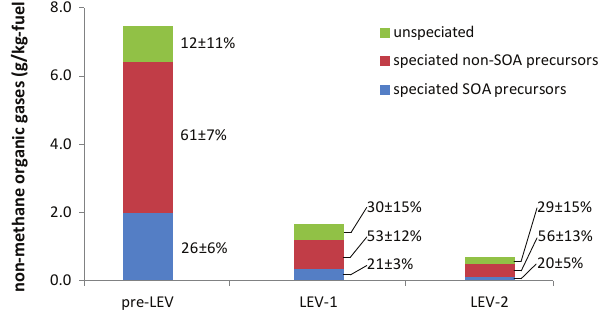
Fig. 3. Median nonmethane organic gas (NMOG) emissions for each class of light-duty gasoline vehicles. The emissions have been lumped into three broad categories: (1) “speciated SOA precursors,” including single-ring aromatics (C 6 to C 12 ), mid-weight VOCs (C 9 to C 12 ); (2) all other speciated compounds (“speciated non-SOA precursors”); and (3) “unspeciated” compounds, defined as the dif- ference between the total NMOG and the speciated emissions. The bars represent the median absolute values; the values next to the bars represent the median ( ± 1 σ ) fractional contribution of each emission category (i.e., precursor, nonprecursor, unspeciated) to the total NMOG for each vehicle